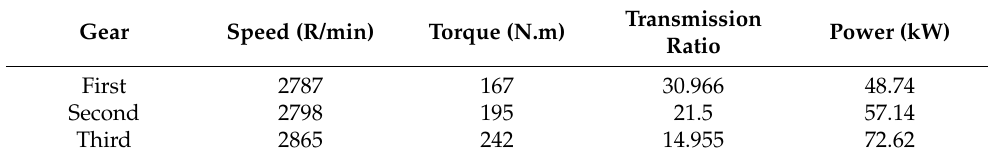
Table 1. Input data of differential inverse gearbox.